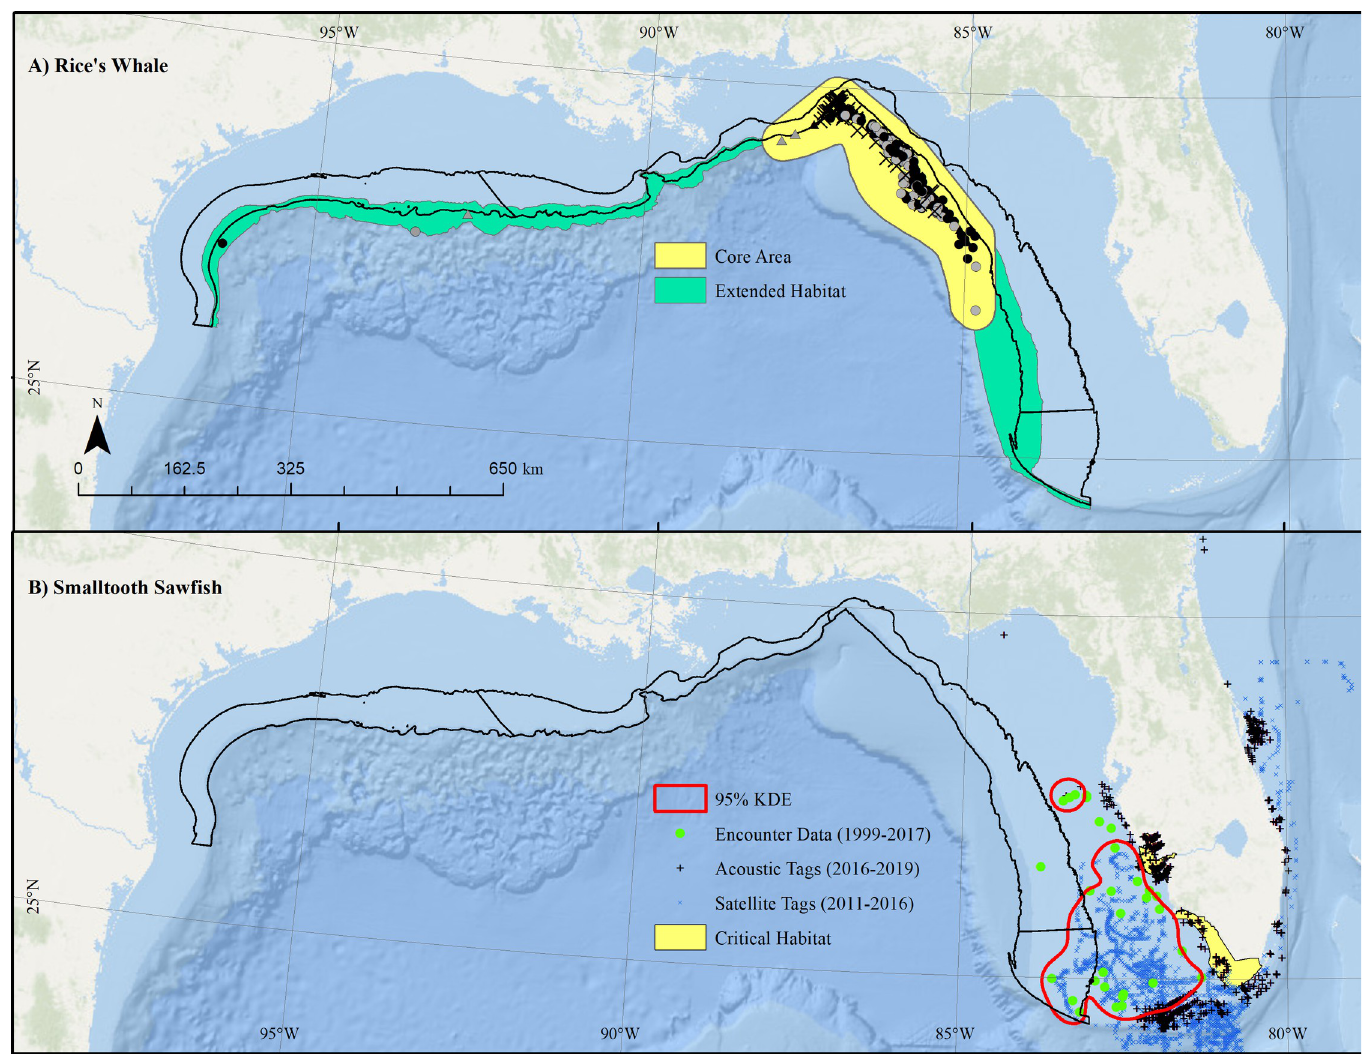
Fig 4. Distribution of Rice’s whale and smalltooth sawfish. Distribution of A) Rice’s whale and B) Smalltooth sawfish relative to proposed Aquaculture Opportunity Atlas study areas (black). Rice’s whale core area (yellow; [20, 21]) distribution polygon based on sightings (black: Rice’s whale, gray: unidentified baleen whale; square: focal follow, triangle: aerial survey, X: satellite tag, circle: ship-based sightin). Extended habitat (green) based on sightings coupled with passive acoustic monitoring (green “extended habitat”). Sawfish high use areas (red line) based on 95% kernel density estimate (KDE) for observations fit to pooled data from Sawfish Encounter Database (1999–2017; ⬤ ), acoustic tag detections (2016–2019; + ), and positioning estimates from satellite tags (2011–2016; � ). Note Sawfish critical habitat (yellow) did not overlap the proposed aquaculture area. Map developed in ESRI ArcGIS 10.8.1. Basemap from Esri Ocean Basemap and its partners, reprinted from ESRI under a CC BY